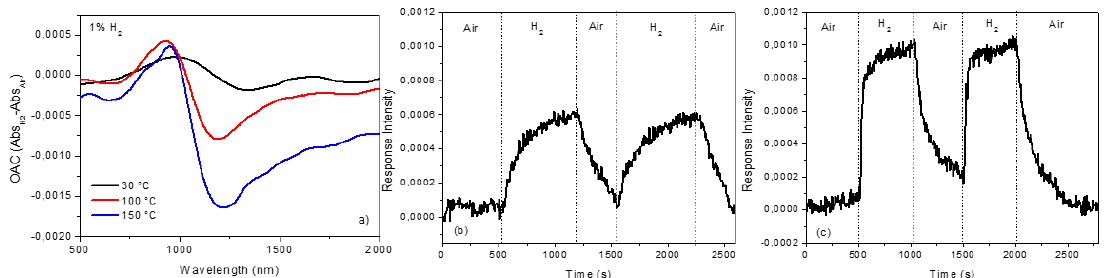
Figure 4. ( a ) Optical Absorbance Change, OAC=Abs H2 -Abs Air , for Au NDs at 30 °C, 100 °C, and 150 °C operative temperature when exposed to 1% H 2 in air. Dynamic cycle air/H 2 /air at 950 nm and 100 °C ( b ) and 150 °C ( c ) operative temperature.